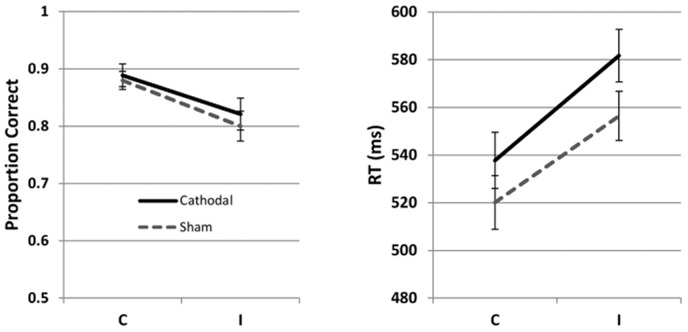
Mean accuracy and reaction times (± SE) in the Flanker task in Experiment 3.The left panel shows mean accuracy, and the right panel shows reaction times. Stimulation was applied during an activity requiring high cognitive control. C  =  Congruent; I  =  Incongruent.